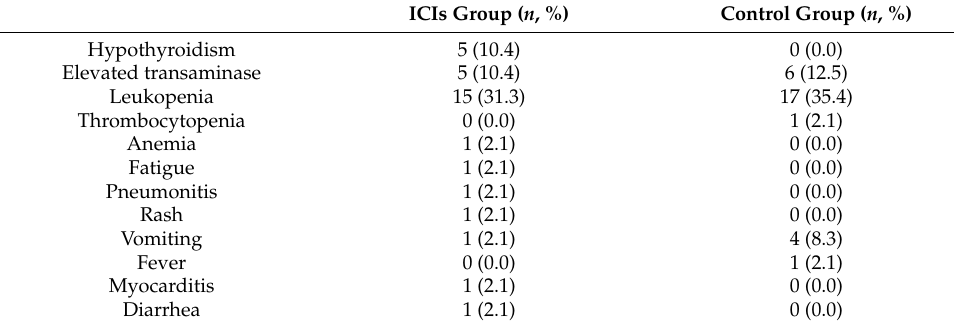
Table 3. Adverse events during